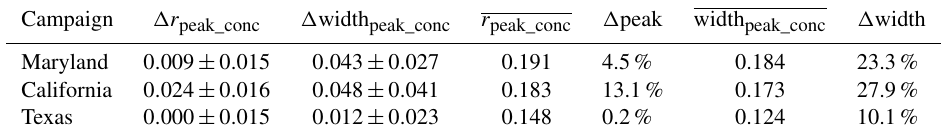
Table 3. Average differences and standard deviations (in µm) in r peak_conc and width peak_conc between AERONET- and LARGE-derived values only for cases that include computed humidification adjustments applied to the LARGE data. Also shown are the AERONET average r peak_conc and width peak_conc values for each campaign and AERONET–LARGE differences as a percentage of average